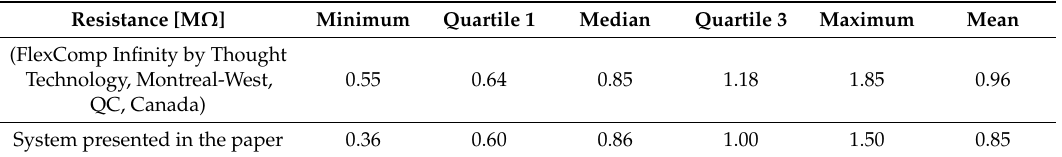
Table 2. Comparison between data gathered from the commercially available system (FlexComp Infinity by Thought Technology) vs. data gathered from the system presented in this paper.